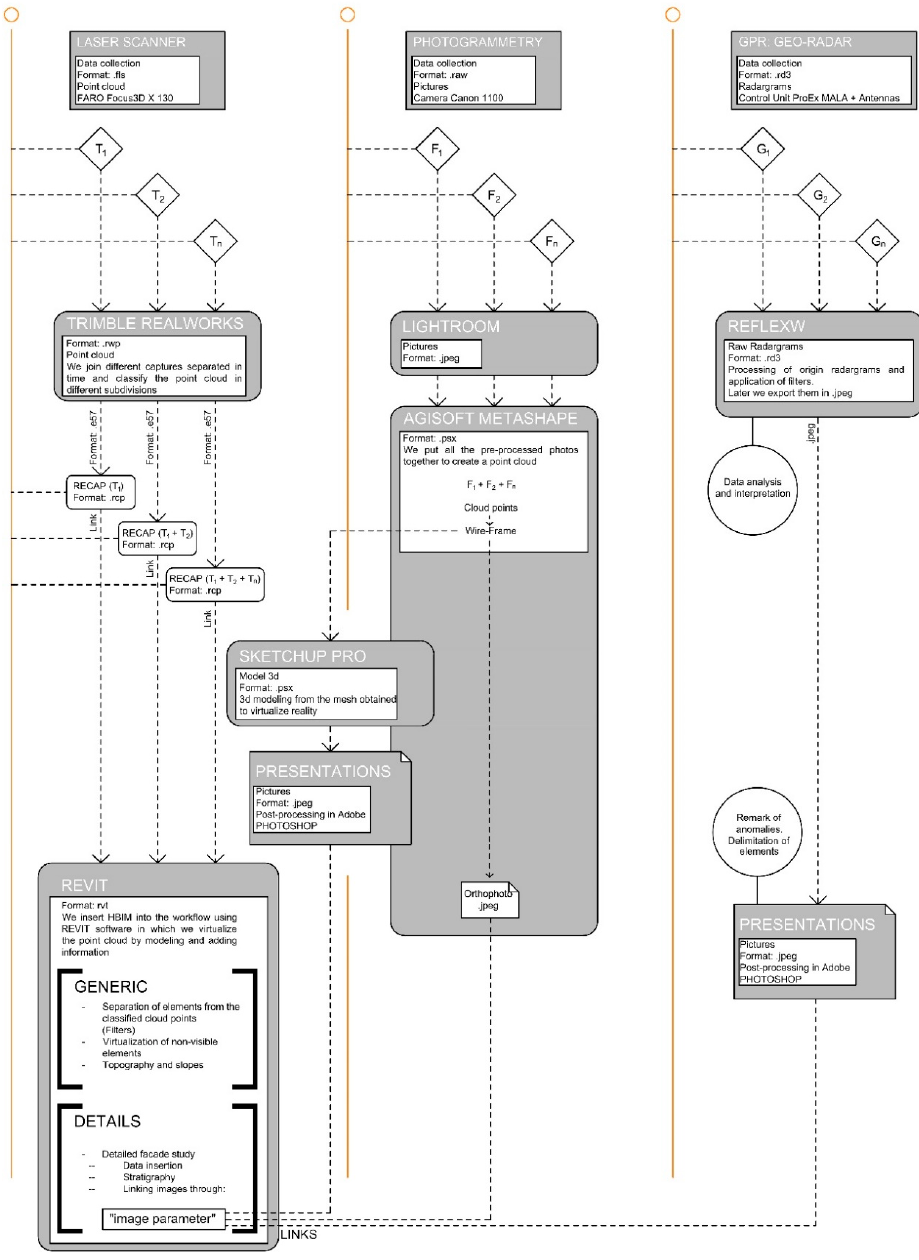
Figure 5. This figure shows the workflow